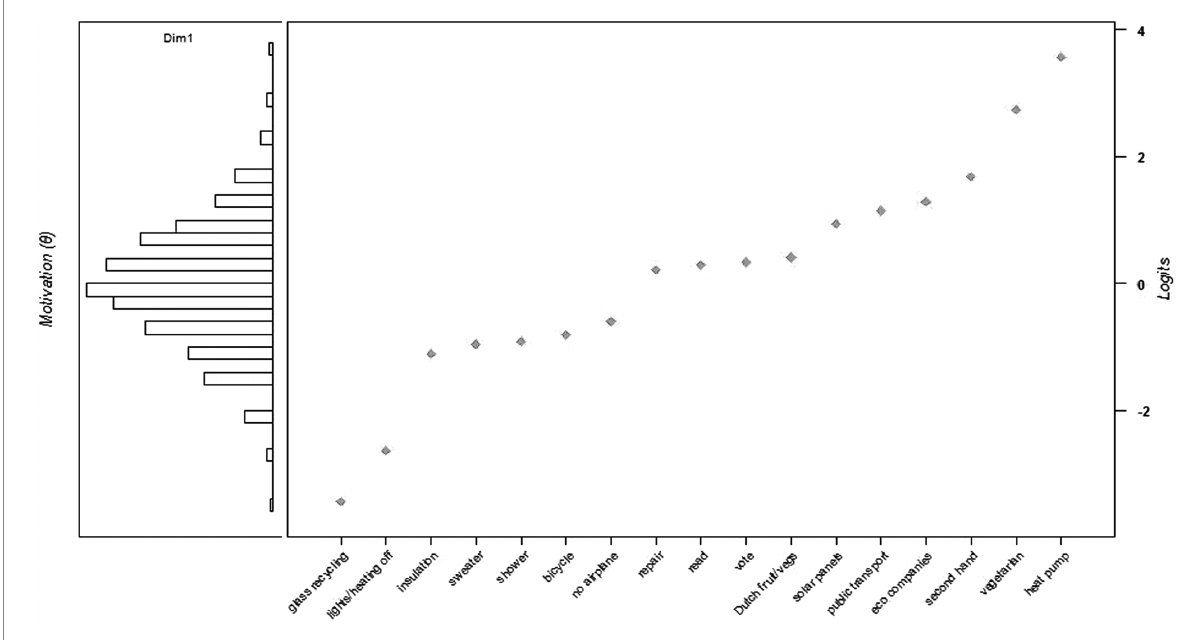
FIGURE 1 Wright map including person motivation ( θ ) and item difficulty ( δ ) of the 17